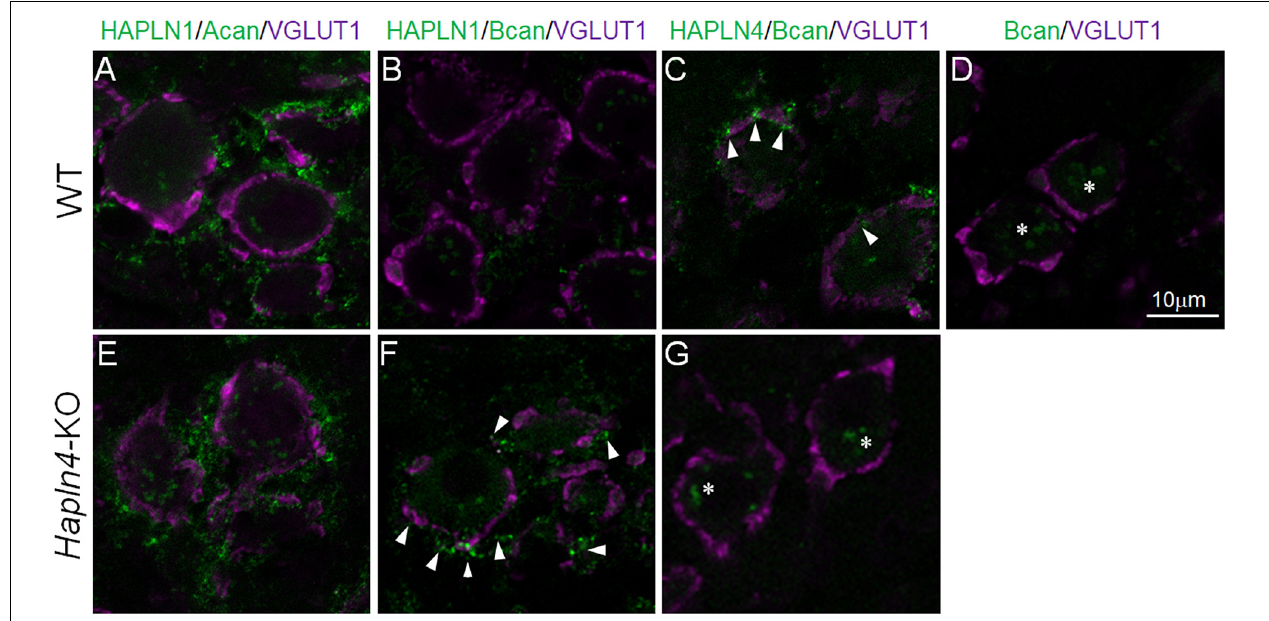
FIGURE 3 | Detection of specific HAPLN–lectican molecular interactions by an in situ proximity ligation assay (PLA). In situ PLA to visualize in situ endogenous HAPLN–lectican interactions (green) in the medial nucleus of the trapezoid body of 5-month-old adult WT (A–D) and KO (E–G) mice using VGLUT1 as a marker of the calyx of Held (magenta). A pair of primary antibodies of HAPLN4 and brevican shows dot signals at the edge or perisynaptic space of the calyx of Held terminals ( C , arrowheads). Notably, in the absence of HAPLN4, brevican shows an ectopic shift of localization to the surrounding neuropil, where HAPLN1 might potentially stabilize brevican in the aberrant condition ( F , arrowheads). The specificity of the PLA reaction is validated with two different negative controls: one is a reaction that omits the anti-HAPLN4 antibody on wild-type tissue (D) ; the other is the PLA reaction of HAPLN4 and brevican using Hapln4 -KO tissue (G) . The non-specific reactions in the negative controls are indicated by asterisks (D,G) . Acan, aggrecan; Bcan, brevican. The scale bar represents 10 µ m.